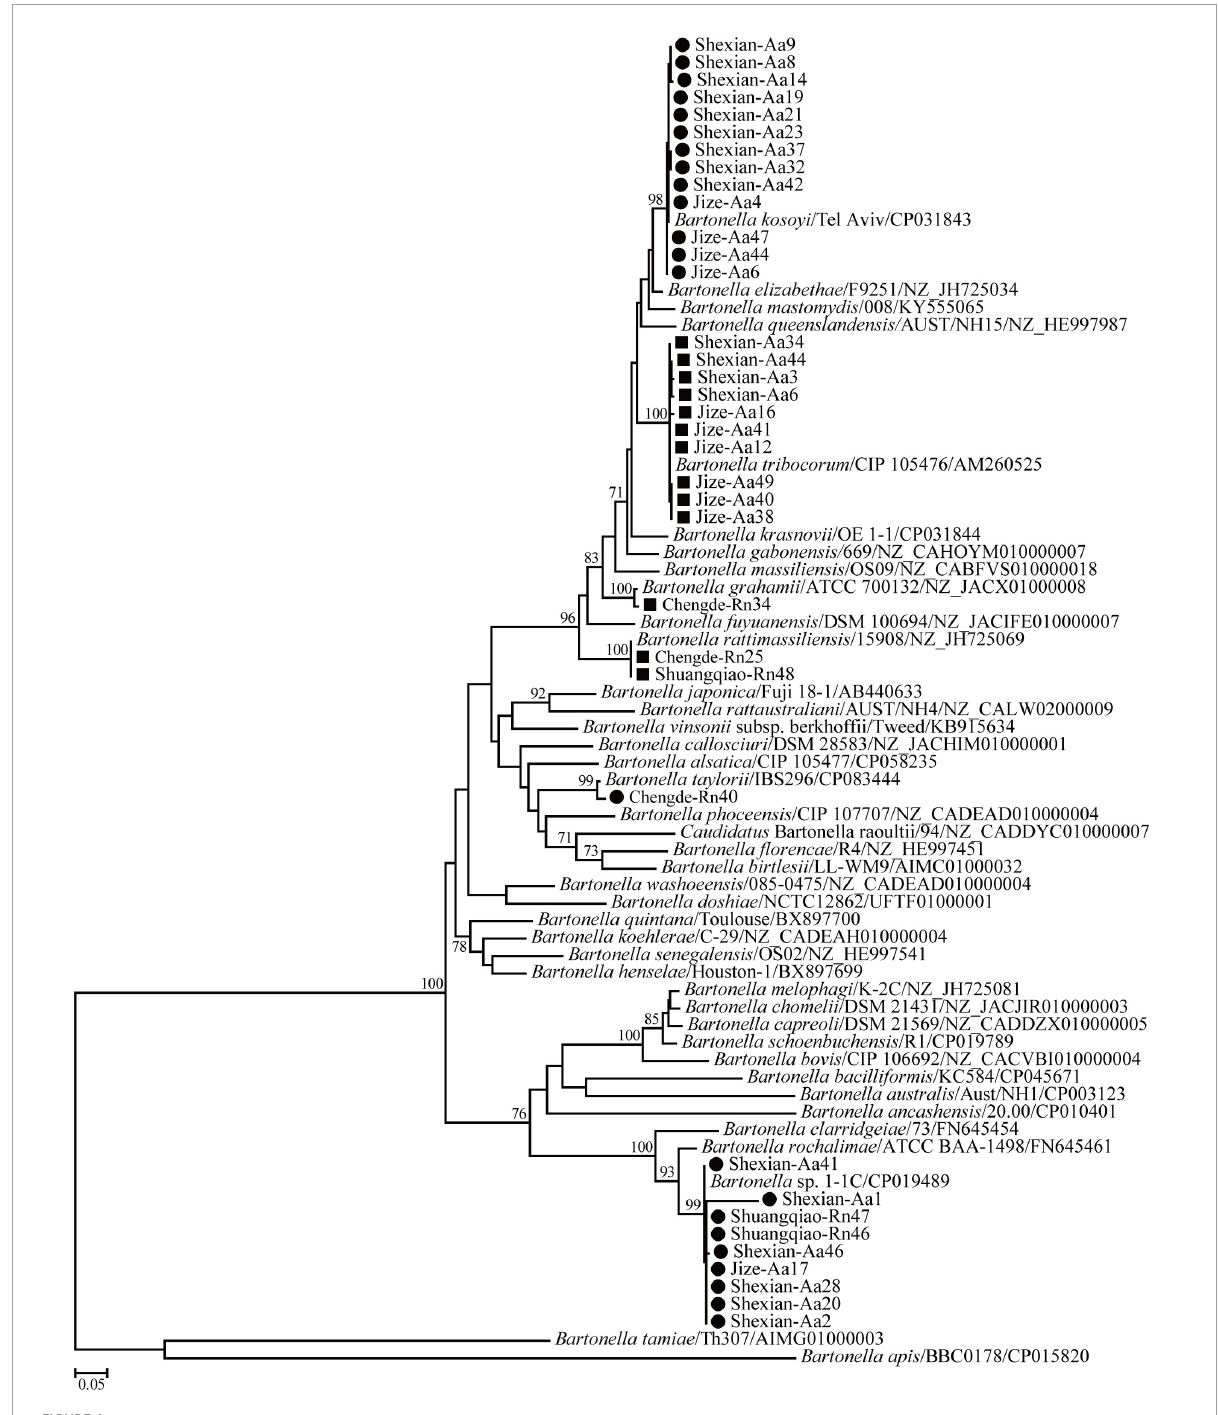
FIGURE4 Maximum-likelihood (ML) tree reconstructed based on the ftsz gene sequences of Bartonella species. The legend follows that of Figure 2 .